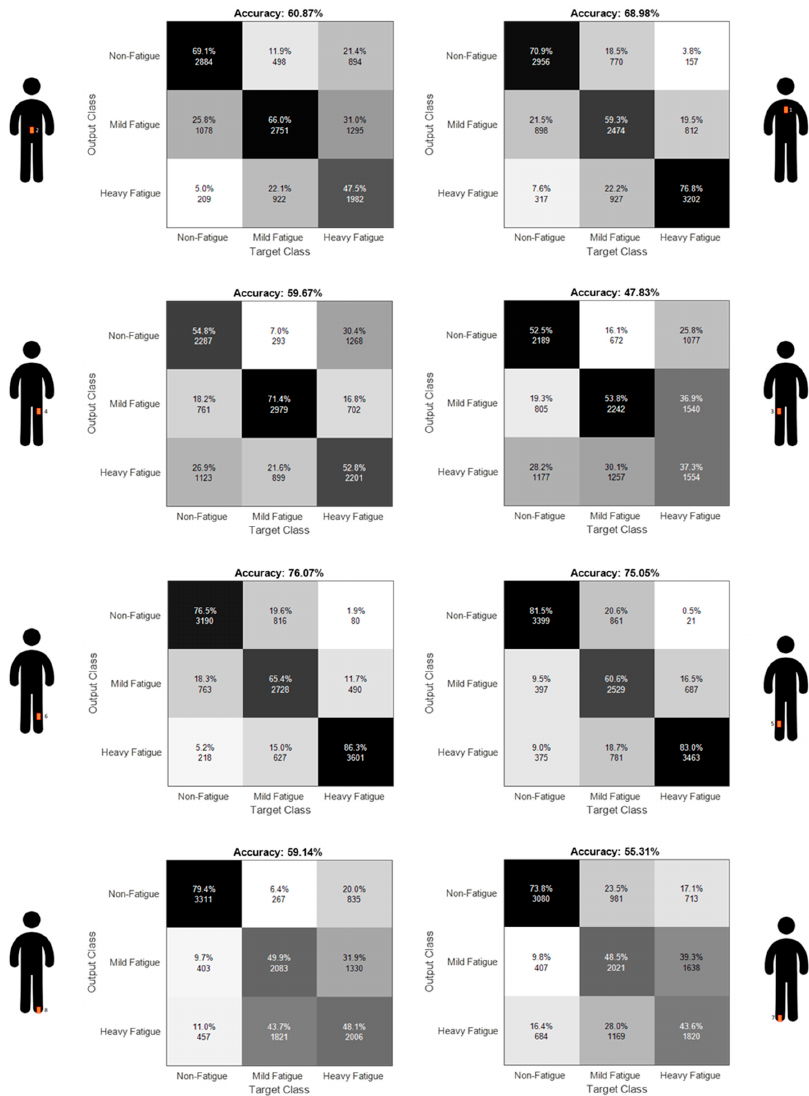
Figure A1. Aggregate confusion matrices with all subjects, minimally intrusive IMU configurations.